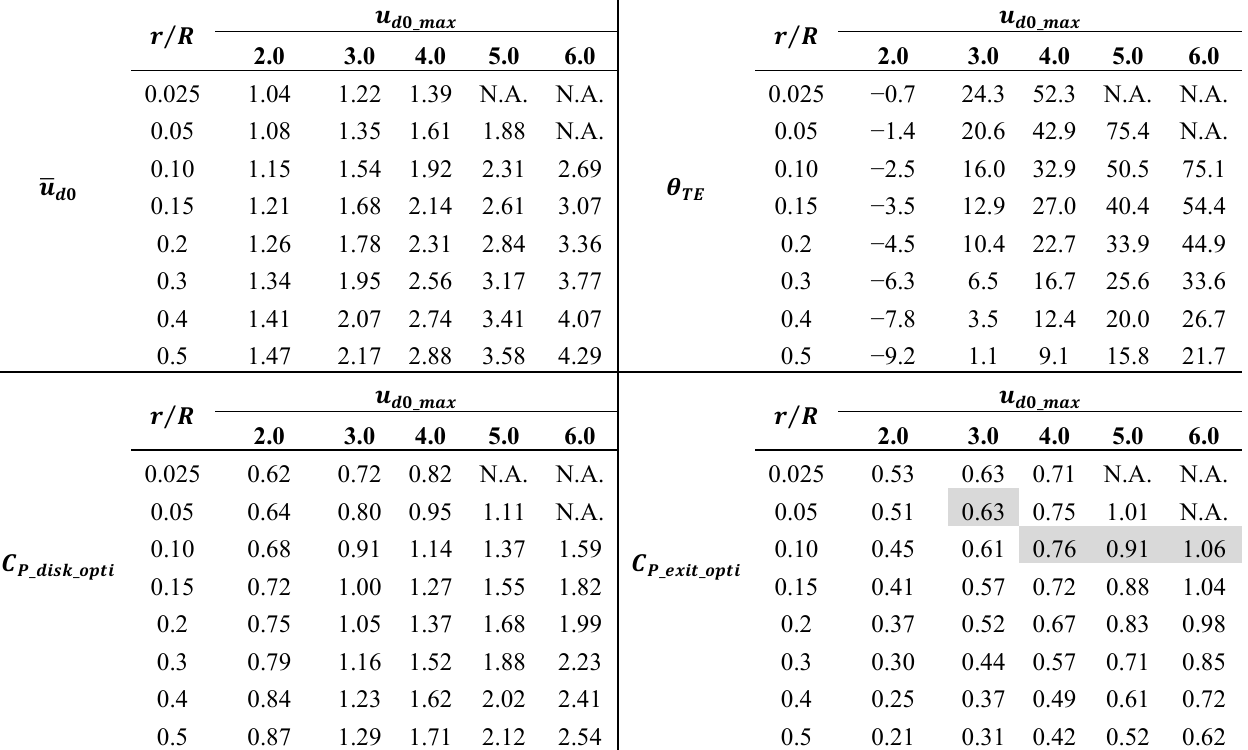
Table 2. (cid:1829) and (cid:1829) predictions based on (cid:1873)(cid:3364) (cid:3017)_(cid:3031)(cid:3036)(cid:3046)(cid:3038)_(cid:3042)(cid:3043)(cid:3047)(cid:3036) (cid:3017)_(cid:3032)(cid:3051)(cid:3036)(cid:3047)_(cid:3042)(cid:3043)(cid:3047)(cid:3036)